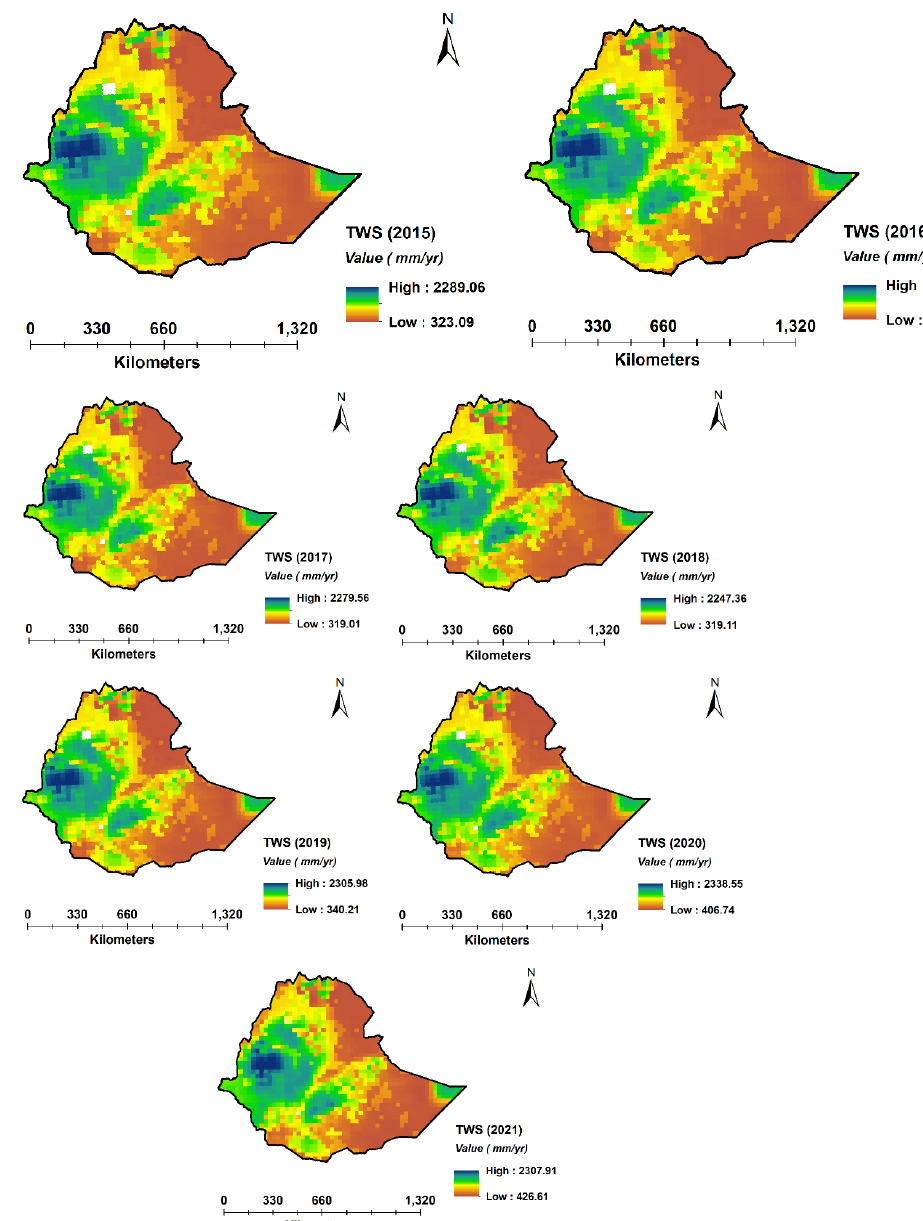
Figure 10. Annual terrestrial water storage (TWS) maps from GLDAS 2 CLM (2015–2021) in Ethio- pia.